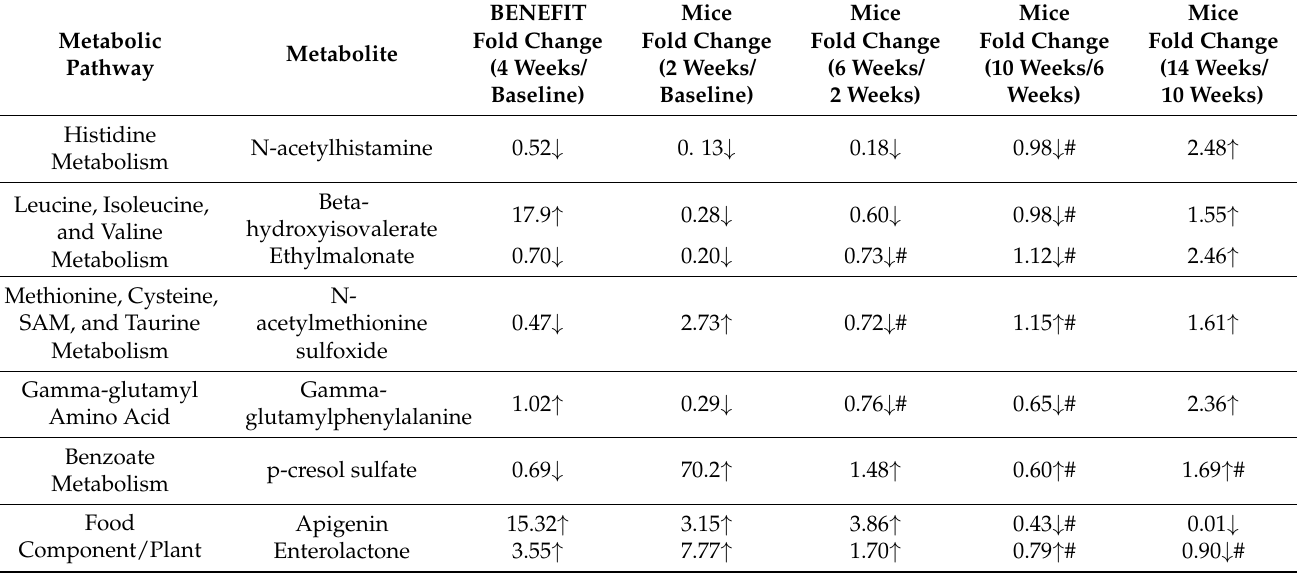
Table 2. Human and murine fecal metabolite changes following dietary rice bran intake. Beans/Bran Enriching Nutritional Eating for Intestinal Health Trial (BENEFIT) rice bran group at 4 weeks compared to the baseline are shown alongside AOM/DSS mice fed rice bran with changes at 2, 6, 10, and 14 weeks compared to the